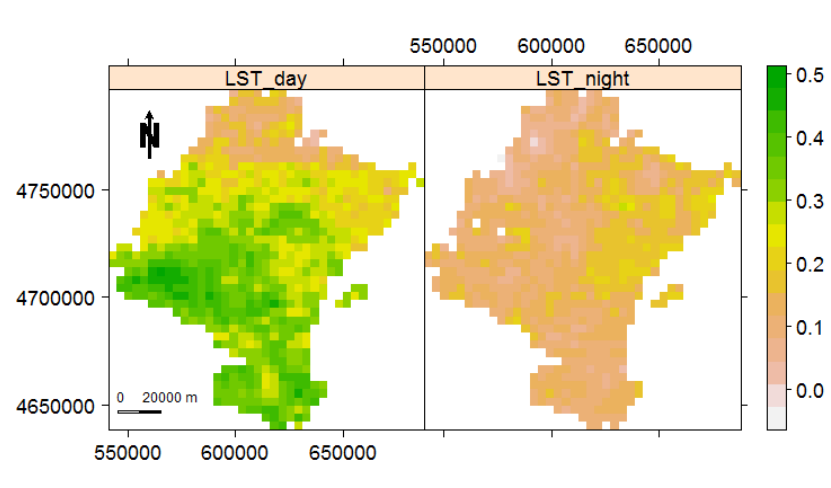
Figure 12. First lag partial autocorrelation for monthly remote sensing LST data of Navarre, Spain, from January 2001 to December 2018. This was obtained from pixel time series individually.